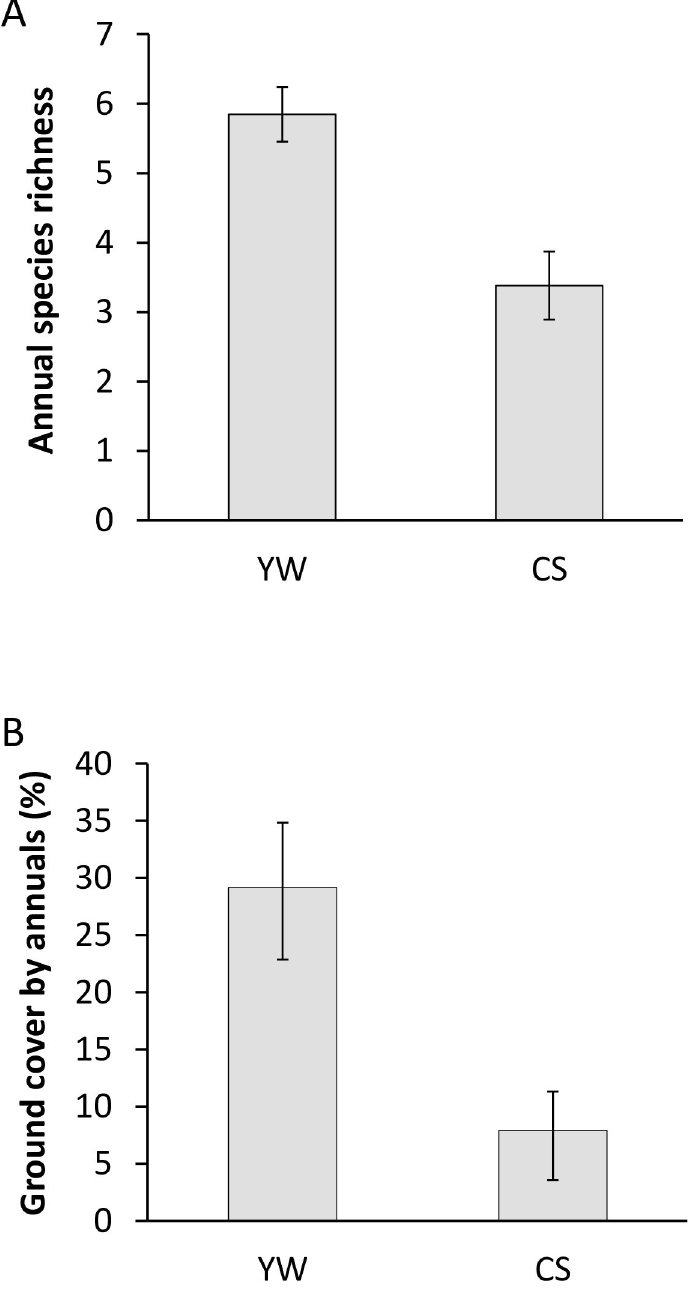
Fig 1. Images characterizing study habitat. Images of creosote scrub (CS; A) and yucca woodland (YW; B) habitats in Ivanpah Valley of Mojave National Preserve, California, USA. Both pictures were taken on the same day in August 2012.